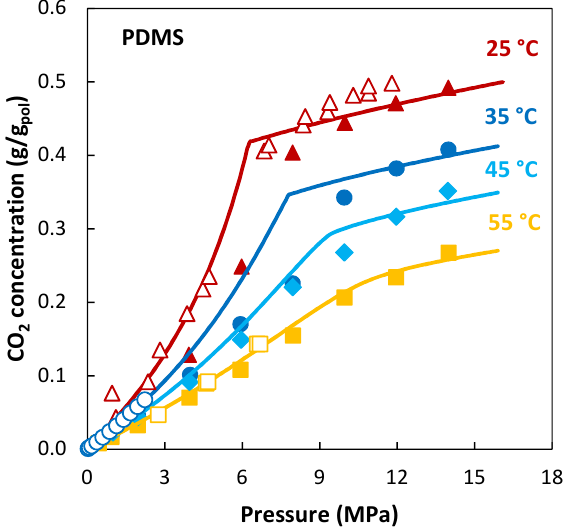
Figure 4. CO 2 sorption in PDMS at different temperatures. Filled symbols: experimental data from [122]: triangles, 25 ◦ C; circles, 35 ◦ C; diamonds, 45 ◦ C; squares, 55 ◦ C. Empty triangles: experimental data from [123] (25 ◦ C). Empty circles: experimental data from [124] (35 ◦ C). Empty squares: experimental data from [125] (50 ◦ C). Lines: LF EoS calculations. Reproduced with permission from [121]. Copyright 2022, Elsevier.